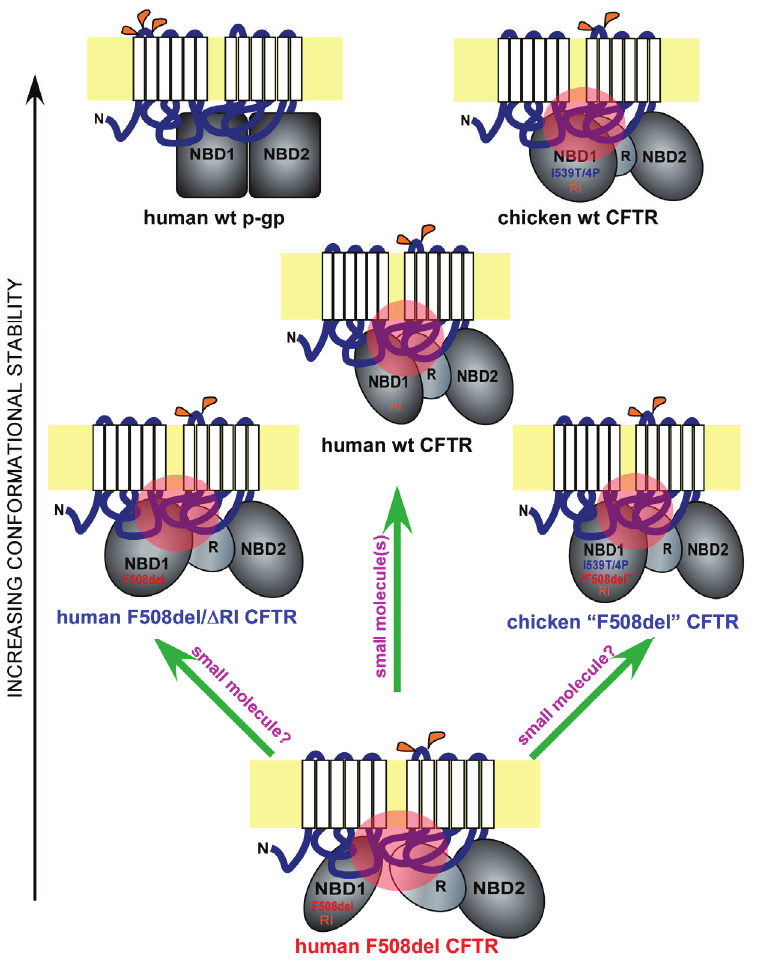
Figure 1. Misfolding and rescue of F508del cystic fibrosis transmembrane conductance regulator (CFTR). Shown are domain conformation of human full-length wild-type (wt) CFTR, its paralogue p-glycoprotein (p-gp), and other CFTR homologues and mutants, as indicated. In each panel, a full-length ABC protein is anchored to the membrane bilayer (in yellow) through two six-pass membrane-spanning domains (white). The extracellular and cytoplasmic loops are in blue, and the major cytoplasmic domains such as the two nucleotide-binding domains (NBD1 and NBD2) and the regulatory domain (R) are in grey. Glycosylation sites on the extracellular loops are labeled in orange (p-gp has three and CFTR has two). The different shapes and orientations of the major cytoplasmic domains represent their different conformations. Key sequence variations in NBD1 are labeled. I539T/4P refers to the combined I539T and four proline substitutions occurring in chicken CFTR. “F508del” refers to the chicken version of the human F508del mutation. RI refers to the presence of the regulatory insertion. Key interdomain contacts for CFTR are labeled by pink circles. The proteins are arranged in the order of conformational stability. Green arrows represent potential F508del rescue